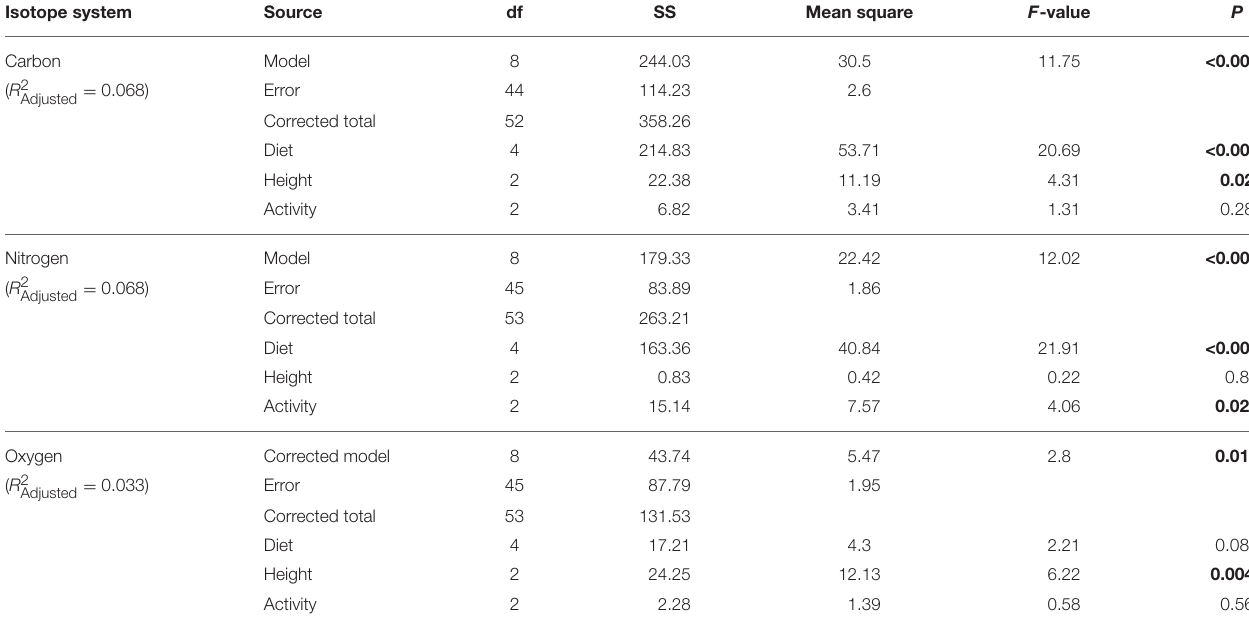
TABLE 3 | General linear model results for diet, foraging height, and diel activity. Isotope system Source df SS Mean square F -value P